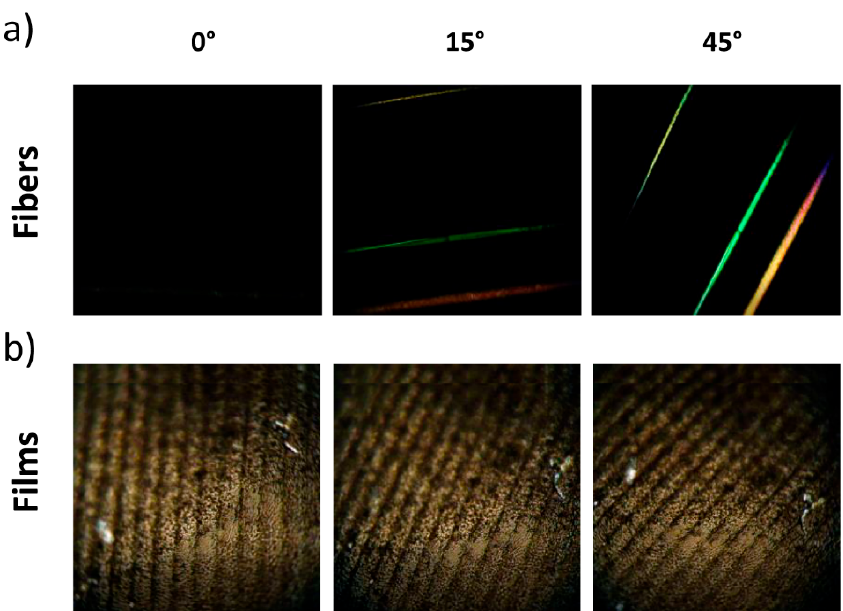
Figure 6. ( a ) 5 wt% P-tCNC fiber (top), neat PU fiber (middle), 1 wt% P-tCNC fiber (bottom) between crossed polarizers oriented at 0°, 15°, 45° relative to the optical filters, showing the anisotropic nature of the fibers. ( b ) 5 wt% P-tCNC nanocomposite film between crossed polarizers oriented at 0°, 15°, 45° relative to the optical filters, showing the isotropic nature of nanocomposite films.